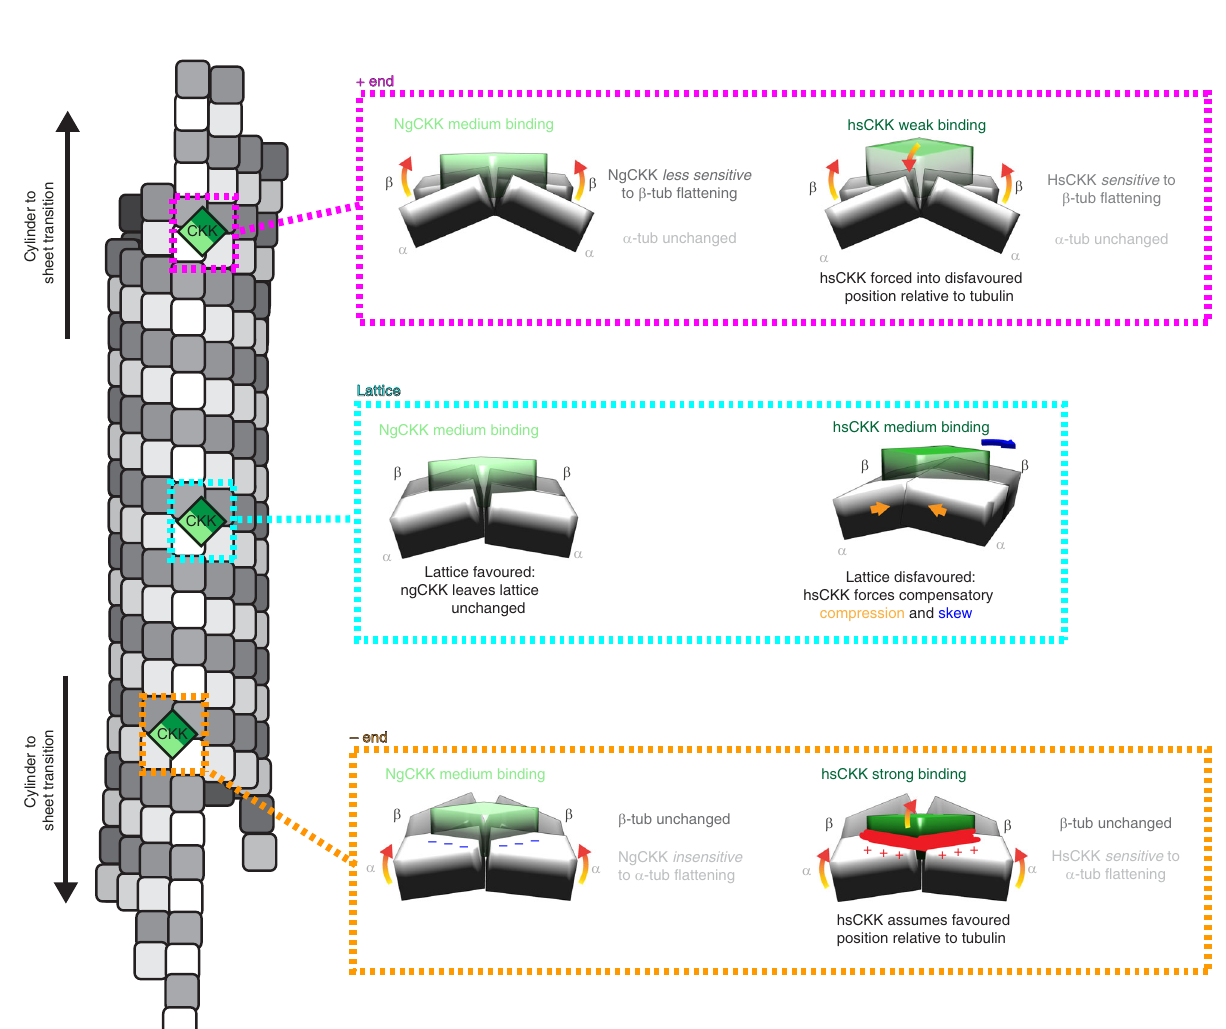
Fig. 5 HsCKK domain rigidity mediates local remodelling of its MT-binding site. a Left, chemical-shift perturbations, coloured by differences in ppm, arising from HsCKK_N1492A binding to MTs mapped on the structure of CKK-MT complex (PDB: 5M5C); the CKK domain is depicted in a ribbon representation while the MT surface is shown as a space- fi lling model; Right, changes of transverse relaxation rates obtained from solution-state NMR CPMG experiments plotted on the 3D structure of the free HsCKK domain; source data are provided as a Source Data fi le. b HsCKK MT binding is accompanied by contraction of the MT diameter; a single turn of models docked within the aligned 13-proto fi lament HsCKK and NgCKK C1 reconstructions are shown viewed from the minus end; arrows indicate the irregular shift of individual proto fi laments. c Contraction of MT diameter is caused by shrinkage of the distance between adjacent dimers; the distance between the centre of masses of each pair of adjacent B-lattice dimers was measured in 13- and 14-proto fi lament C1 HsCKK and NgCKK models; all data points are plotted and bars represents mean ± SD; differences between HsCKK and NgCKK models are statistically signi fi cant ( p < 0.0001, t-test); source data are provided as a Source Data fi le. d Top, alignment of a single dimer from the NgCKK-tubulin and HsCKK-tubulin C1 models shows HsCKK induces compression and shear between the dimers at its binding site; bottom, RMSD of backbone positions in top panel. e Schematic summarising modi fi cations imposed by HsCKK but not kinesin or NgCKK binding on MT architecture; modi fi cations are exaggerated for clarity